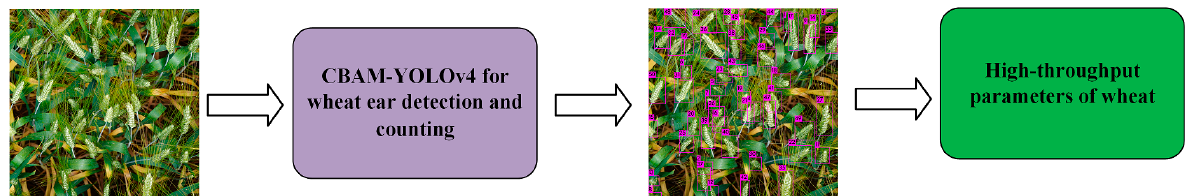
Figure 13. Compare the results of wheat ear counts with different density distributions.